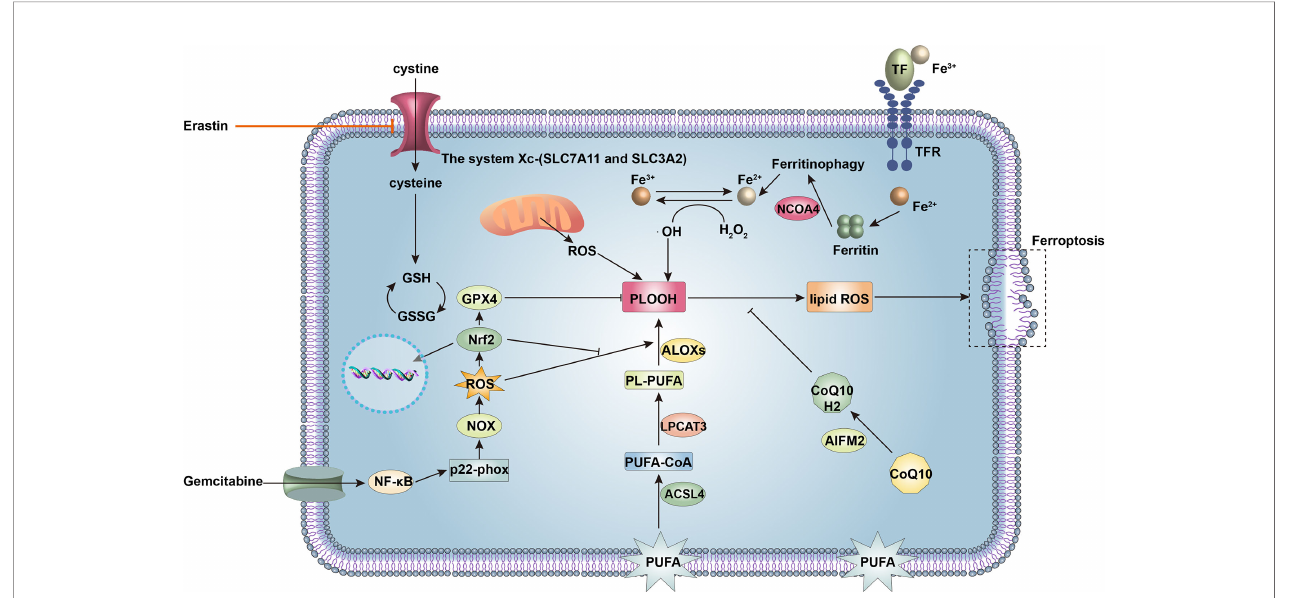
FIGURE 4 | Signaling molecules and pathways regulating ferroptosis and gemcitabine resistance in cancer cells. Ferroptosis is a form of cell death driven by iron accumulation and lipid peroxidation. The acyl-CoA synthetase long-chain family member 4 (ACSL4)-lysophosphatidylcholine acyltransferase 3 (LPCAT3)-arachidonate lipoxygenases (ALOXs) pathway enzymatically mediates oxidation of polyunsaturated fatty acids (PUFAs) of the plasma membrane to phospholipid hydroperoxide (PLOOH), ultimately leading to ferroptosis. Nuclear receptor coactivator 4 (NCOA4) induces ferritinophagy to increase intracellular iron, promoting non-enzymatic lipid peroxidation and inducing ferroptosis. However, glutathione peroxidase 4 (GPX4) inhibits lipid peroxidation together with glutathione (GSH), which prevents ferroptosis. Intracellular levels of GSH are maintained by the system X c − (solute carrier family 7 member 11, SLC7A11 and solute carrier family 3 member 2, SLC3A2), which accepts extracellular cystine for GSH synthesis. In addition, apoptosis-inducing factor mitochondrial 2 (AIFM2) maintains a reduced state of coenzyme Q 10 (CoQ10H2) to prevent lipid peroxidation and ferroptosis. Therefore, upregulation of SLC7A11, GSH, GPX4, and AIFM2 expression renders cancer cells resistant to ferroptosis. Gemcitabine can increase reactive oxygen species (ROS) production via nuclear factor kappa-B (NF- k B)-p22 -phox -nicotinamide adenine dinucleotide phosphate oxidase (NOX) pathway in pancreatic ductal adenocarcinoma (PDAC) cells to induce ferroptosis. Activation of nuclear erythroid 2-related factor (Nrf2) decreases ROS and suppresses